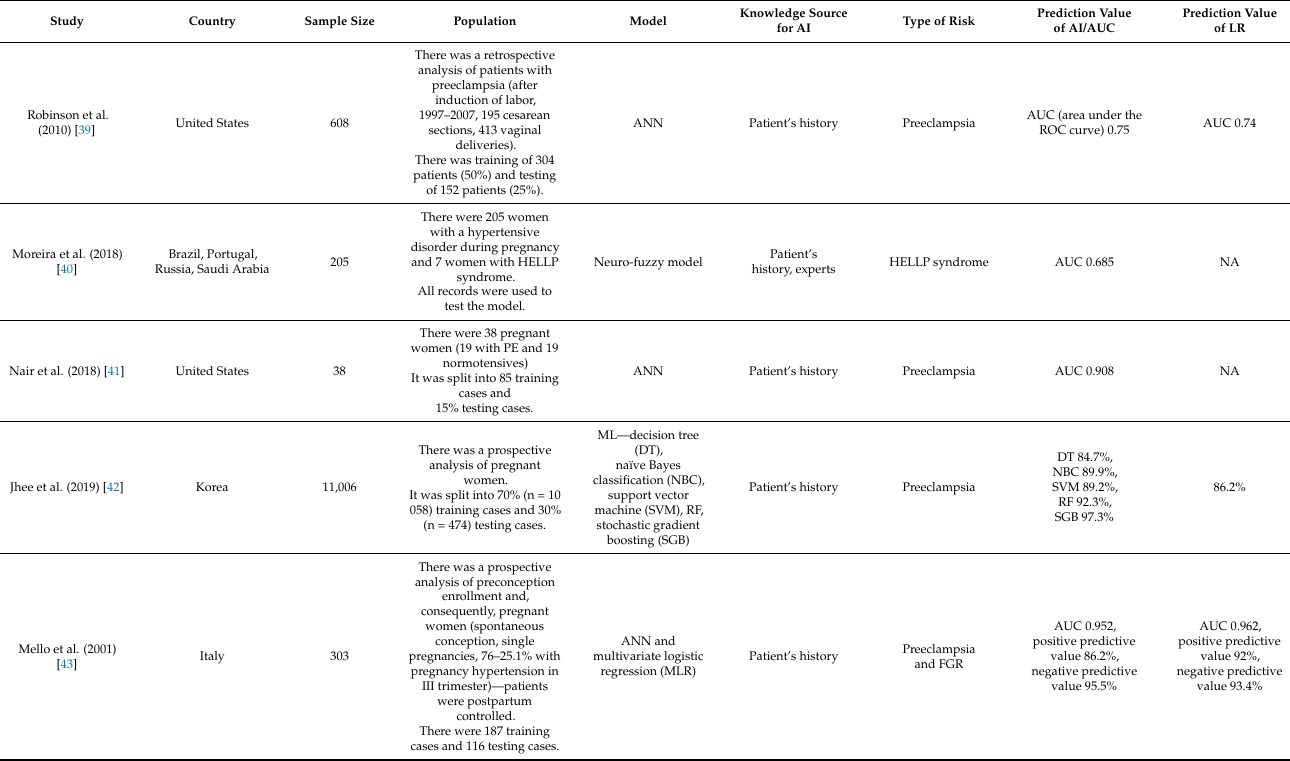
Table 4. Characteristics of included studies on